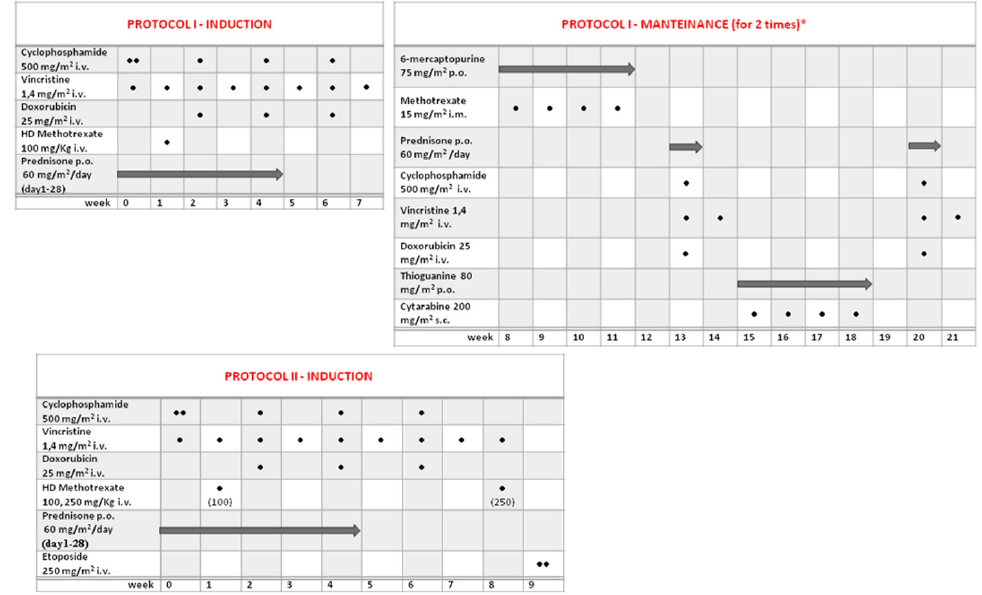
Figure 1. Protocol I scheme with induction (7 weeks) and maintenance (8–21 weeks for 2 times); protocol II scheme with induction (9 weeks) and the same maintenance as protocol I only for T-LBL histology.